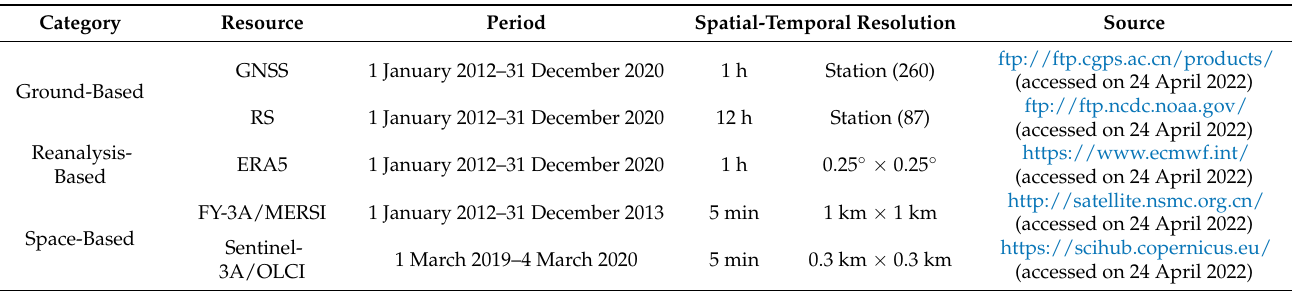
Table 1. Specific information of the data used for the establishing CPRAP.